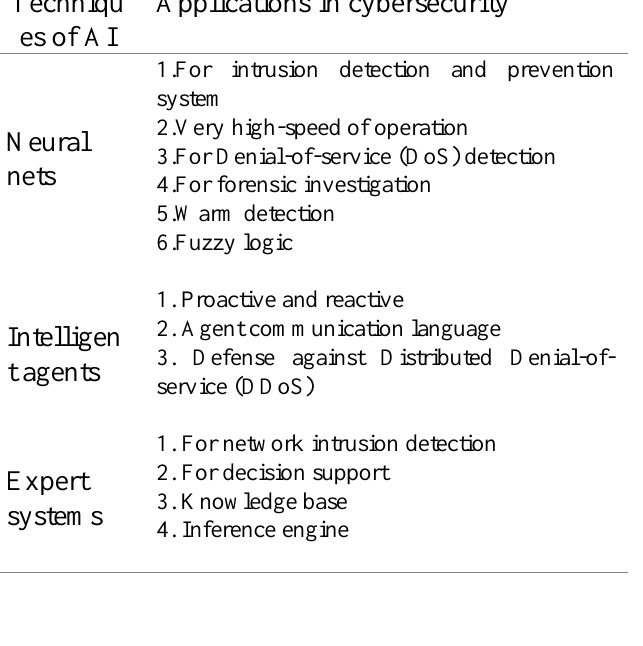
Table 1. Techniques and applications of